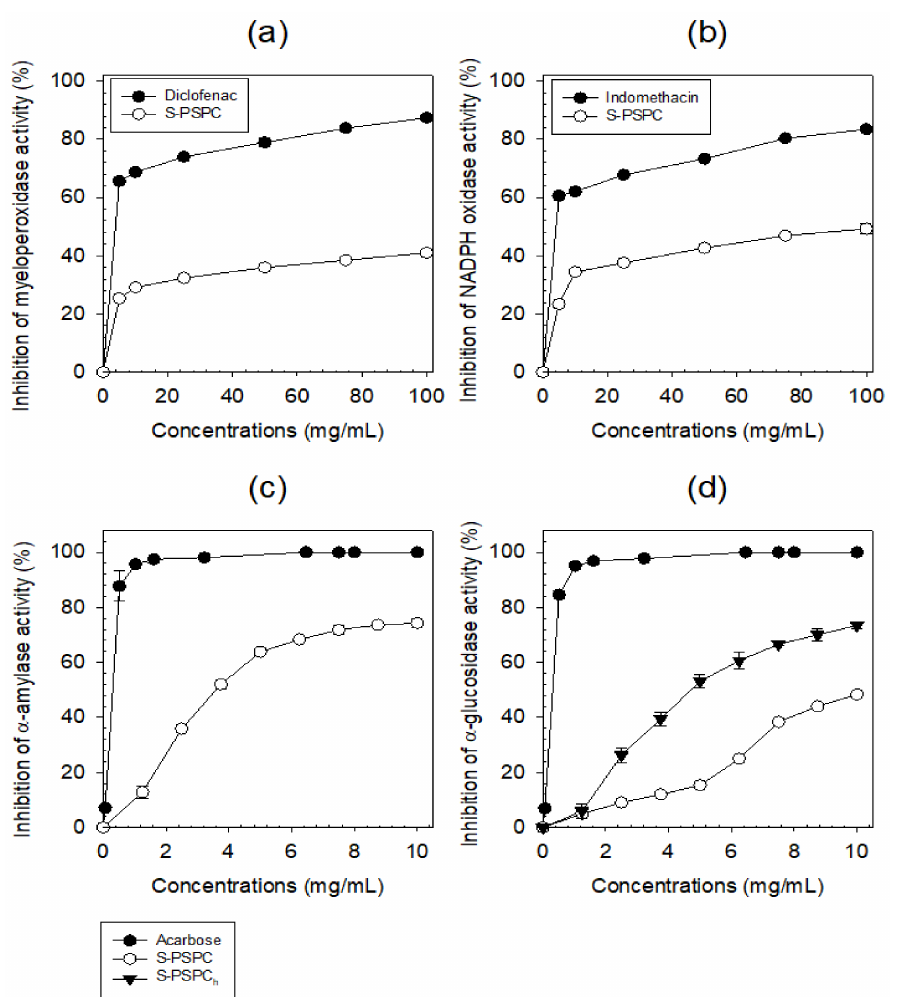
Figure 5. In vitro anti-inflammatory and anti-hyperglycemic effects of S-PSPC regarding inhibitions of ( a ) myeloperoxidase, ( b ) NADPH oxidase, ( c ) α -amylase and ( d ) α -glucosidase activities. S-PSPC h is a hydrolyzed version of S-PSPC (H 2 SO 4 , 50 ◦ C, 30 min) for preliminary investigations of molar mass effects (data not